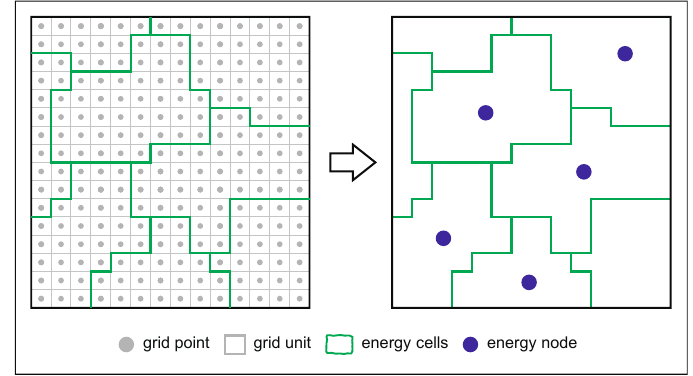
Figure 2. Visualization grid point, energy cell and energy node.